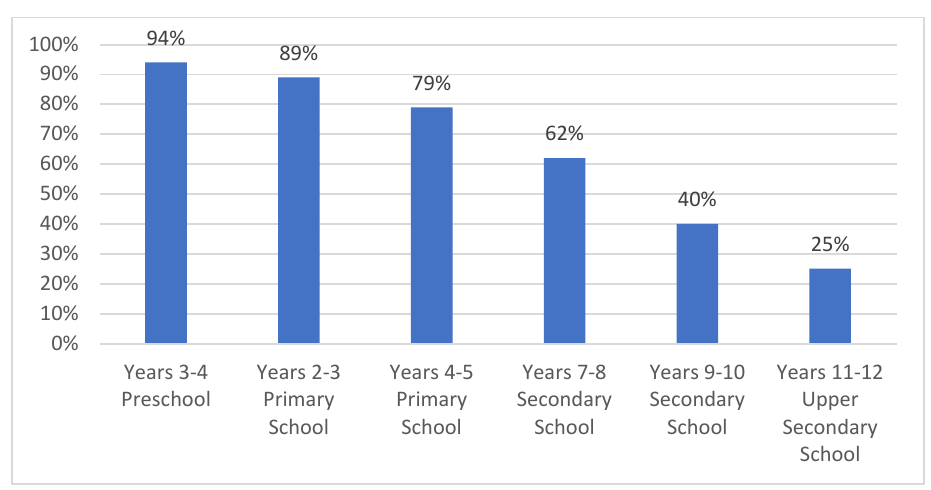
Figure 1. Parents who allow access to the Internet only with explicit permission.